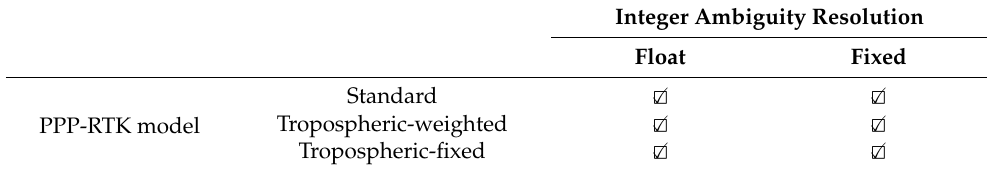
Table 2. Cases of the PPP-RTK positioning